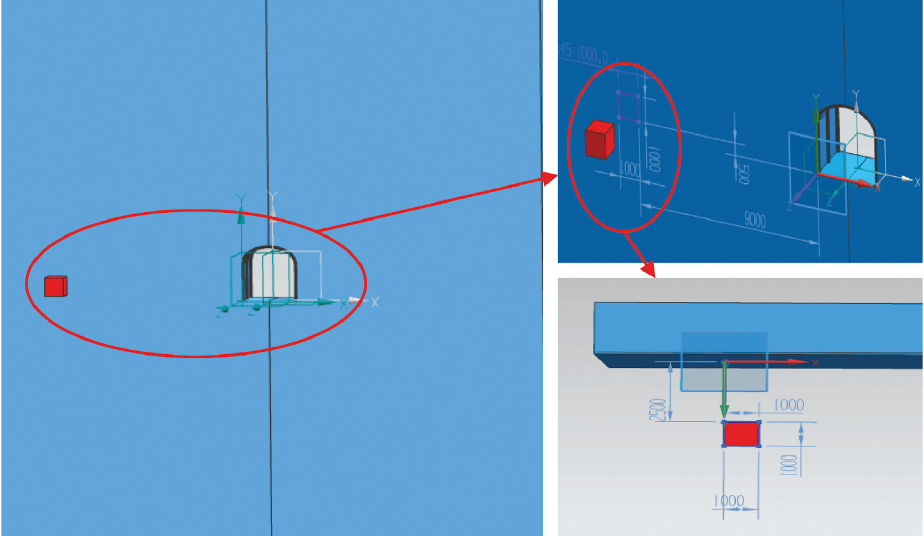
Figure 12: Dynamic impact model diagram. The blue model represents the rock mass, the black one represents the U-shaped steel, the red square represents the dynamic impact block, and the dynamic impact block from the laneway is ( x : − 9 . 0 ,y : 0 . 5 ,z : 2 . 5 )